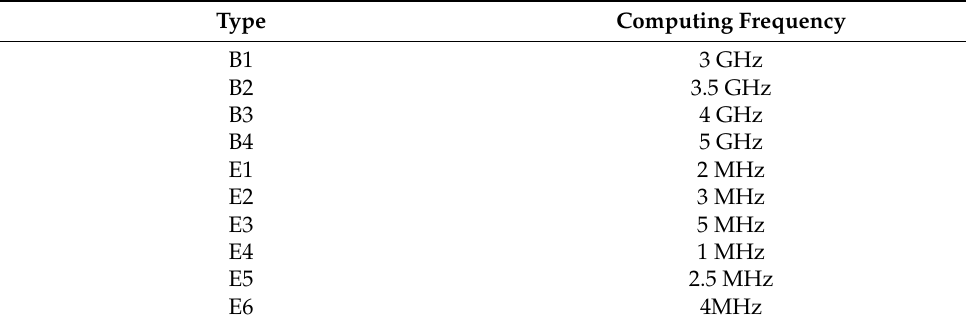
Table 2. Performance of Each